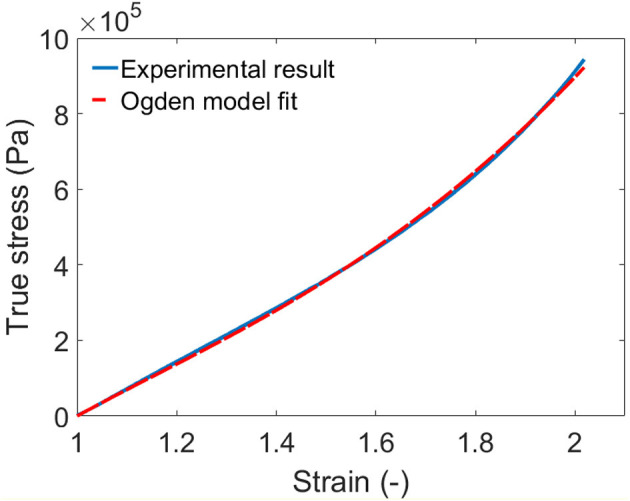
Pure shear test of the silicone elastomer and the Ogden model fit.